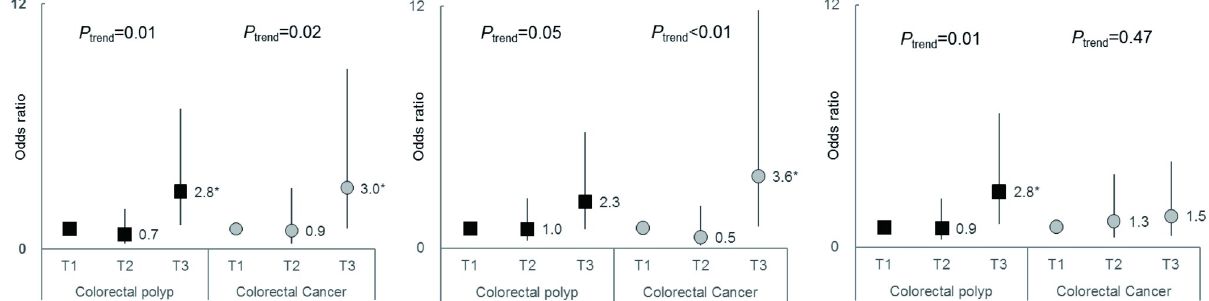
Fig 1. Associations between the summary measures of persistent organic pollutants, organochlorine pesticides, and polychlorinated biphenyls and the risk of colorectal polyps or cancer, calculated using polychotomous logistic regression. (A) ∑ POPs. (B) ∑ OCPs. (C) ∑ PCBs Odds ratios adjusted for age, sex, family history, body mass index, cigarette smoking, alcohol drinking, physical activity, meat consumption, diabetes, and fiber intake. � Confidence interval does not contain 1. ∑ POPs = ∑ OCPs + ∑ PCBs; ∑ OCPs = β -hexachlorocyclohexane + ∑ DDTs + ∑ chlordanes + ∑ heptachlor; ∑ PCBs = ∑ low-chlorinated PCBs + ∑ mid-chlorinated PCBs + ∑ high-chlorinated PCBs. DDT, dichlorodiphenyltrichloroethane; OCP, organochlorine pesticide; PCB, polychlorinated biphenyl; POP, persistent organic